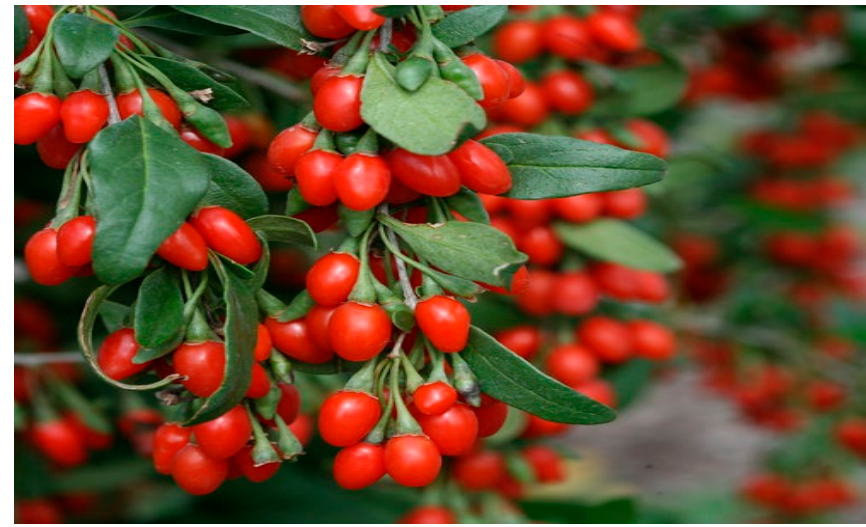
Figure 9. Image of Lycium barbarum plant. Source: [113].